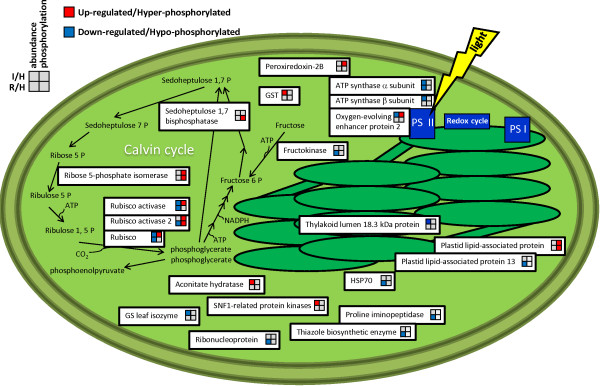
Grapevine proteins with predicted plastid localization changing their quantitative and/or phosphorylation levels in infected and recovered plants. The model gives an overview of the quantitative and qualitative (phosphorylation) changes in chloroplast-localized proteins, showing their involvement in specific metabolic pathways and predicted integration into biological networks according to the KEGG database. The expression trends are represented using a coloured legend in the upper left corner of the figure.